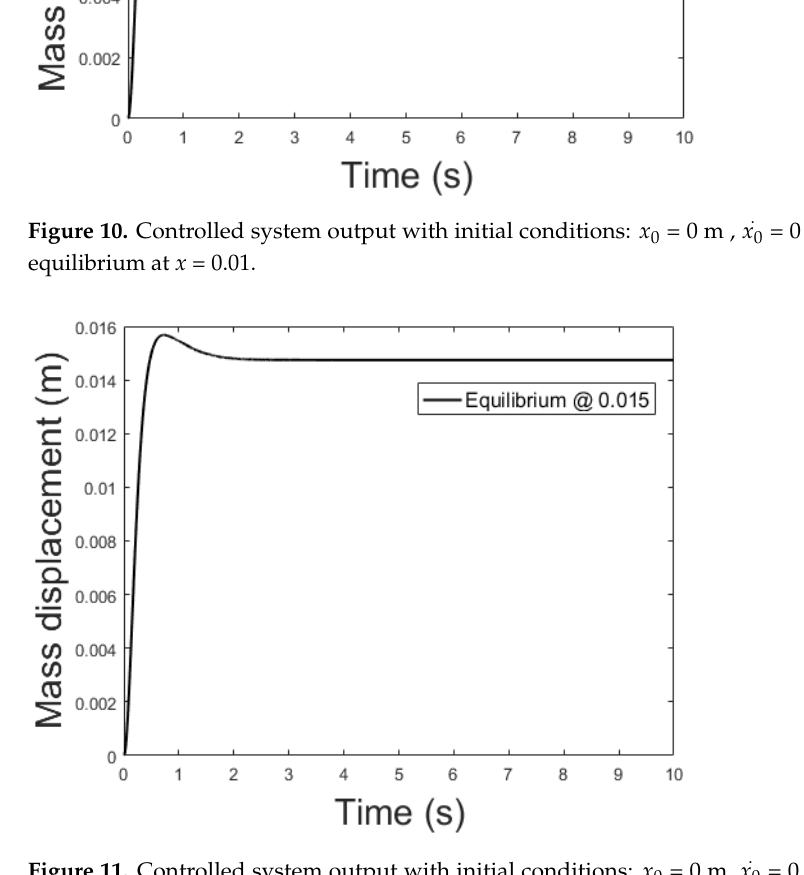
Figure 11. Controlled system output with initial conditions: x 0 = 0 m, equilibrium at x =